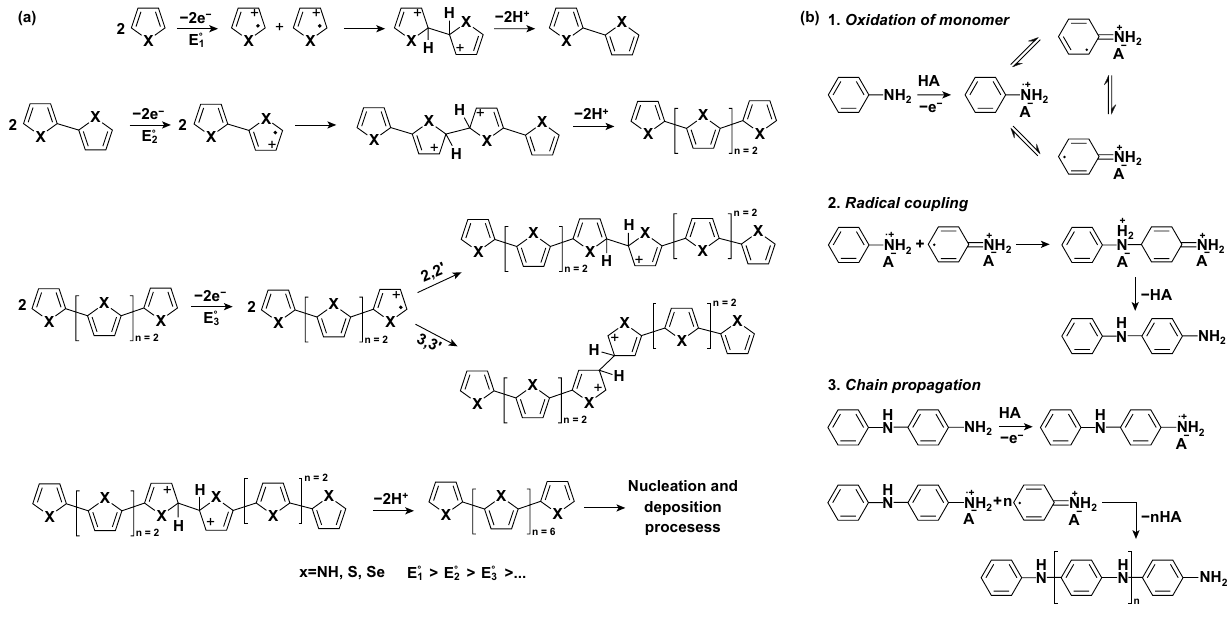
Fig. 10 a Electrochemical polymerization mechanism of pyrrole. Adapted from Ref. [133] with permission. b Electrochemical polymerization mechanism of polyaniline. Adapted from Ref. [135] with